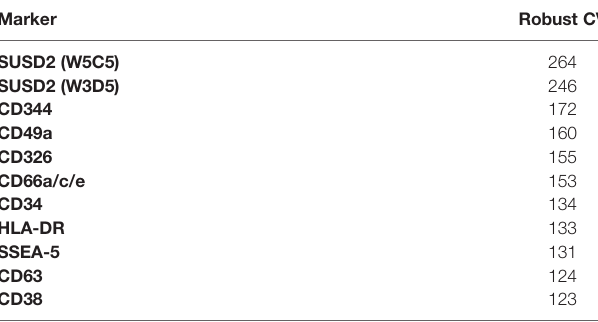
TABLE 2 | The 10 markers from the LEGENDScreen analysis with the highest robust coef fi cient of variation (robust CV).